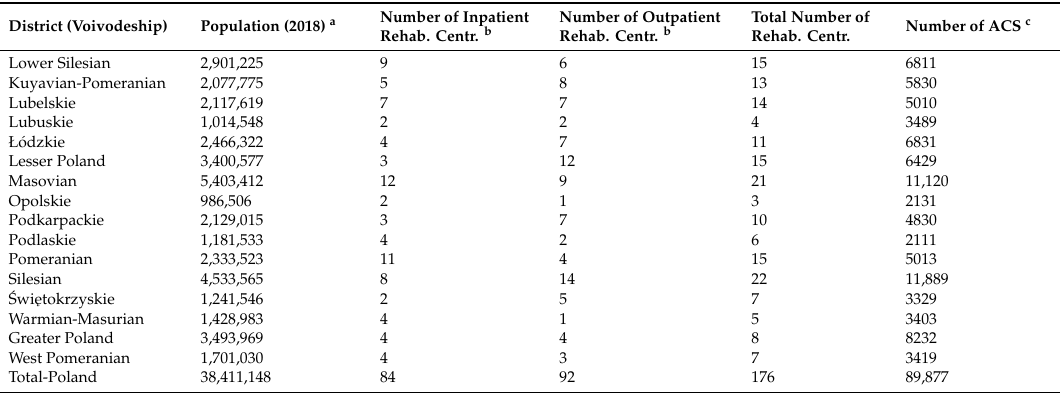
Table 1. Number of cardiological rehabilitation centers and number of acute coronary syndromes (ACS) in Polish districts (voivodeships) in